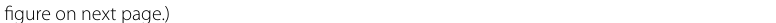
figure on next Fig. 1 Sequence and phylogenetic analysis of CxEXL22. A The predicted domain organization of CxEXL22; B sequence alignment of CxEXL22, BsEXLX1 from Bacillus subtilis (GenBank: AHH91628.1), EXPB1 from Zea mays (NCBI: XP_008659972.2), and ScExlx1 from Schizophyllum commune (GenBank: AKN44794.1); C phylogenetic tree of